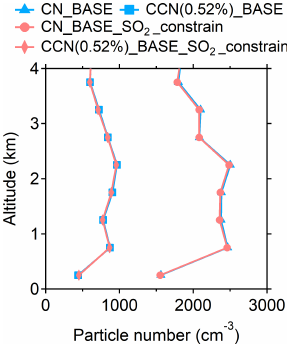
Figure A6. Vertical profiles of the simulated number concentrations (STP) of CN and CCN at 0.52% supersaturation averaged along the observation trajectories within the planetary boundary layer (PBL).